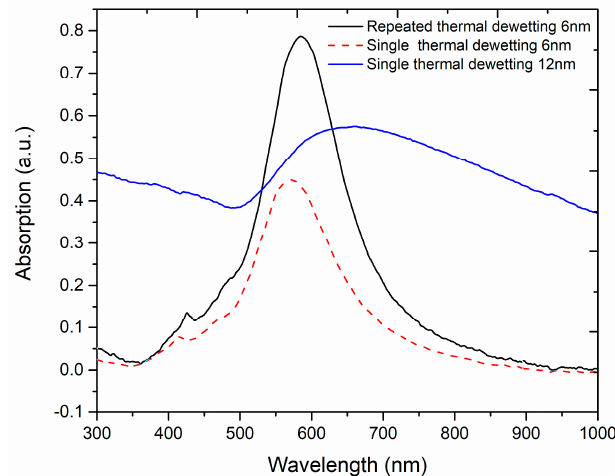
Figure 10. Absorption spectra of nanostructures in planar samples prepared by single step and repeated dewetting of 6 nm thick gold film and of a sample prepared by single step dewetting of an Au film 12 nm thick film.